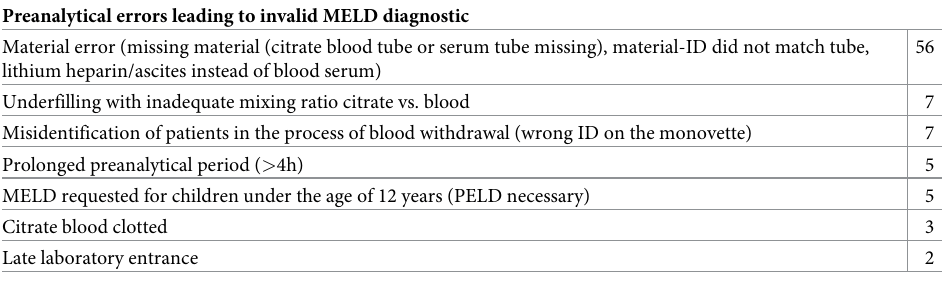
Table 2. Table with preanalytical errors leading to not reporting MELD score. Preanalytical errors leading to invalid MELD